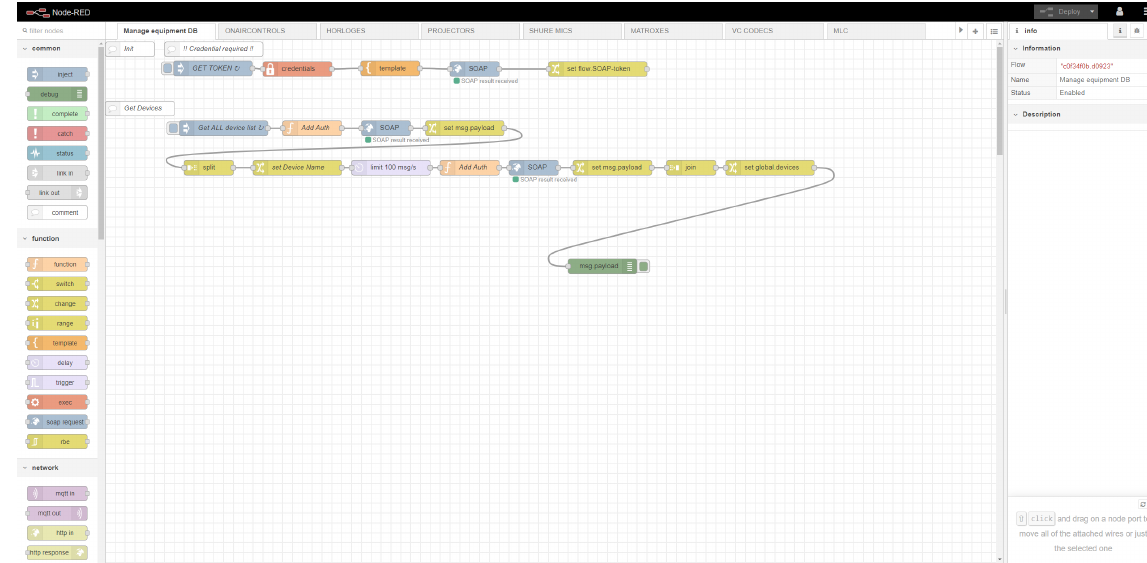
Figure 6. Node-red flow panel showing a flow to retrieve devices from our network